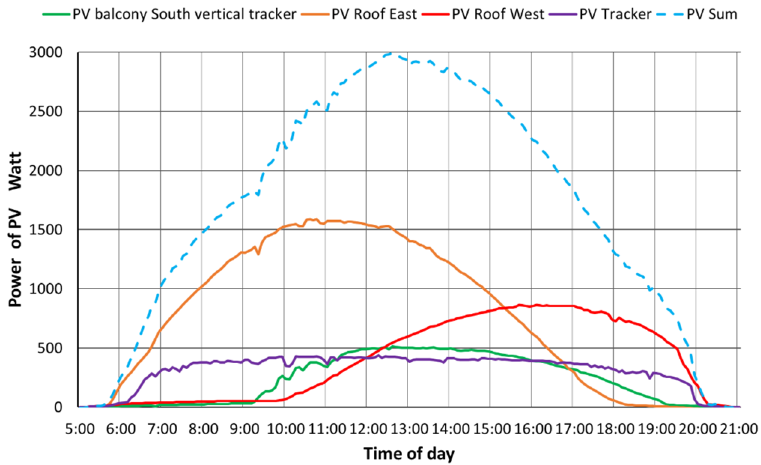
Figure 1. Power generated by PVS on sunny day on 6 June 2020.